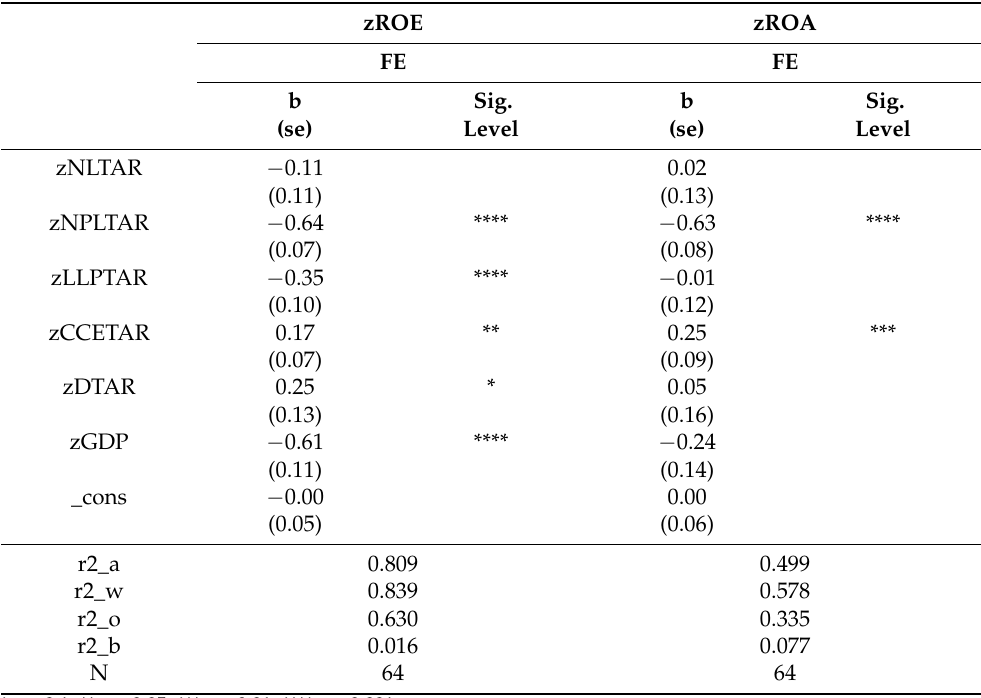
Table 6. Regression results for fixed effects models for ROE and ROA with standardized variables.